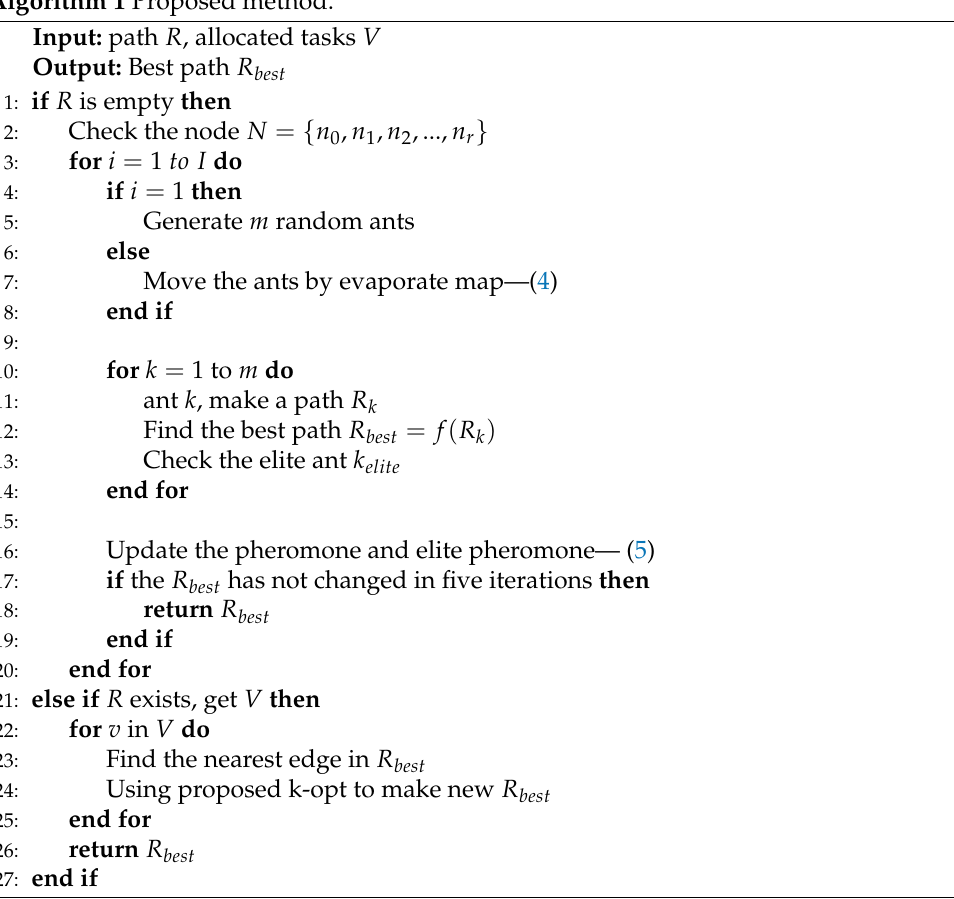
Algorithm 1 Proposed